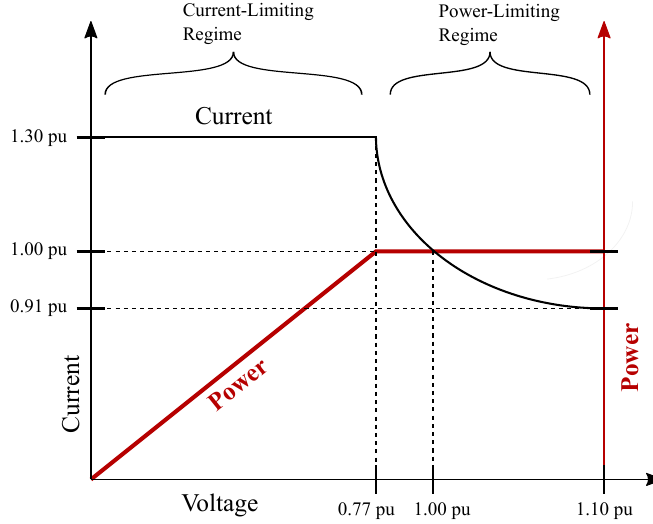
Figure 6. Graphical illustration of constraints for a grid-following